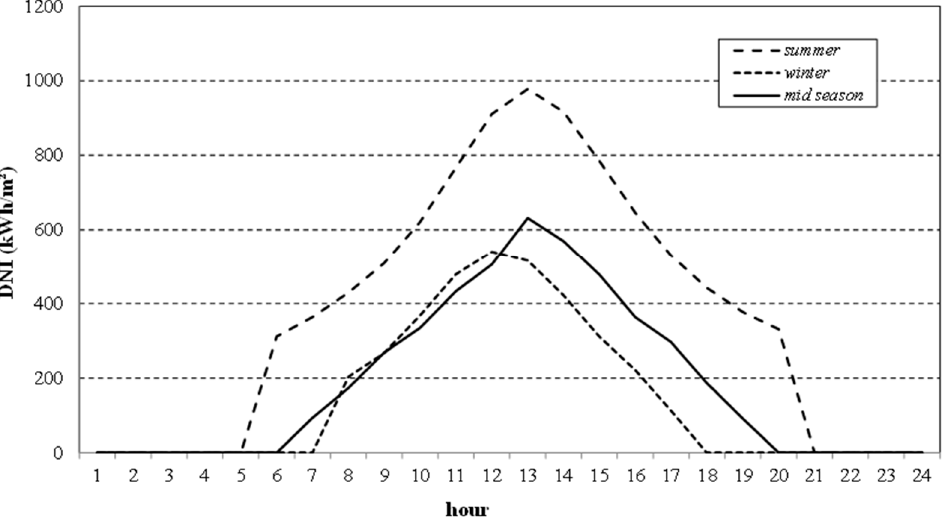
Figure 4. Direct normal irradiation in the summer, winter, and middle seasons,.